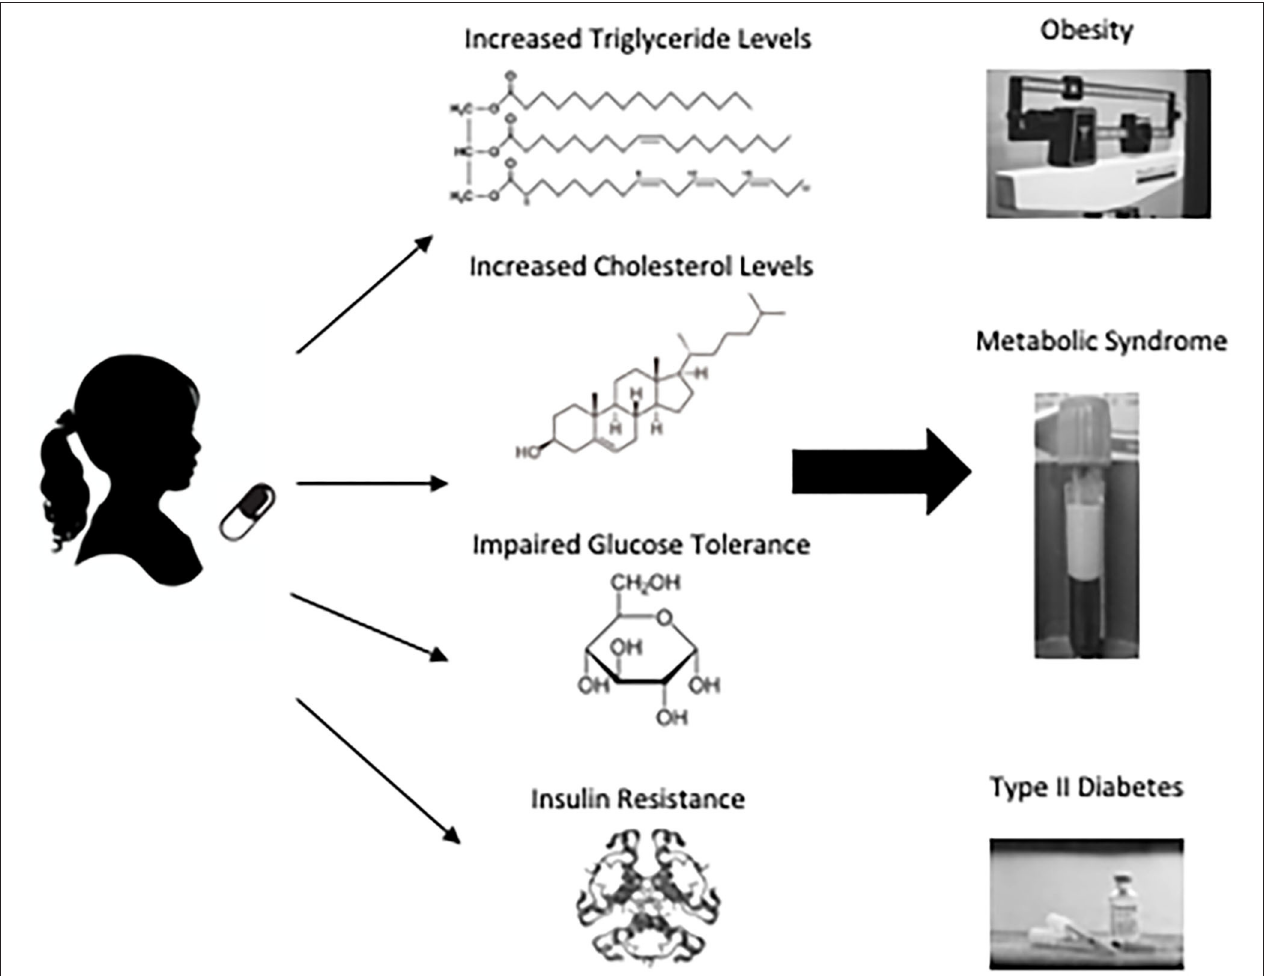
FIGURE 2 | Possible mechanisms of antipsychotic adverse metabolic effects. The energy homeostasis pathway is complex and provides numerous possible mechanisms that might explain AP-related weight gain and metabolic effects. Arrow at end of line indicates activation of pathway and perpendicular bar denotes inhibition. Neuroendocrine signaling molecules are bolded. Potential AP inputs are italicized and represented by dotted lines. ARC, arcuate nucleus; LH, lateral hypothalamus; NPY, neuropeptide Y; AgRP, agouti-related peptide; POMC, pro-opiomelanocortin; NPYR, neuropeptide Y receptor; MC4R, Melanocortin 4 Receptor; α -MSH, alpha-Melanocyte-stimulating